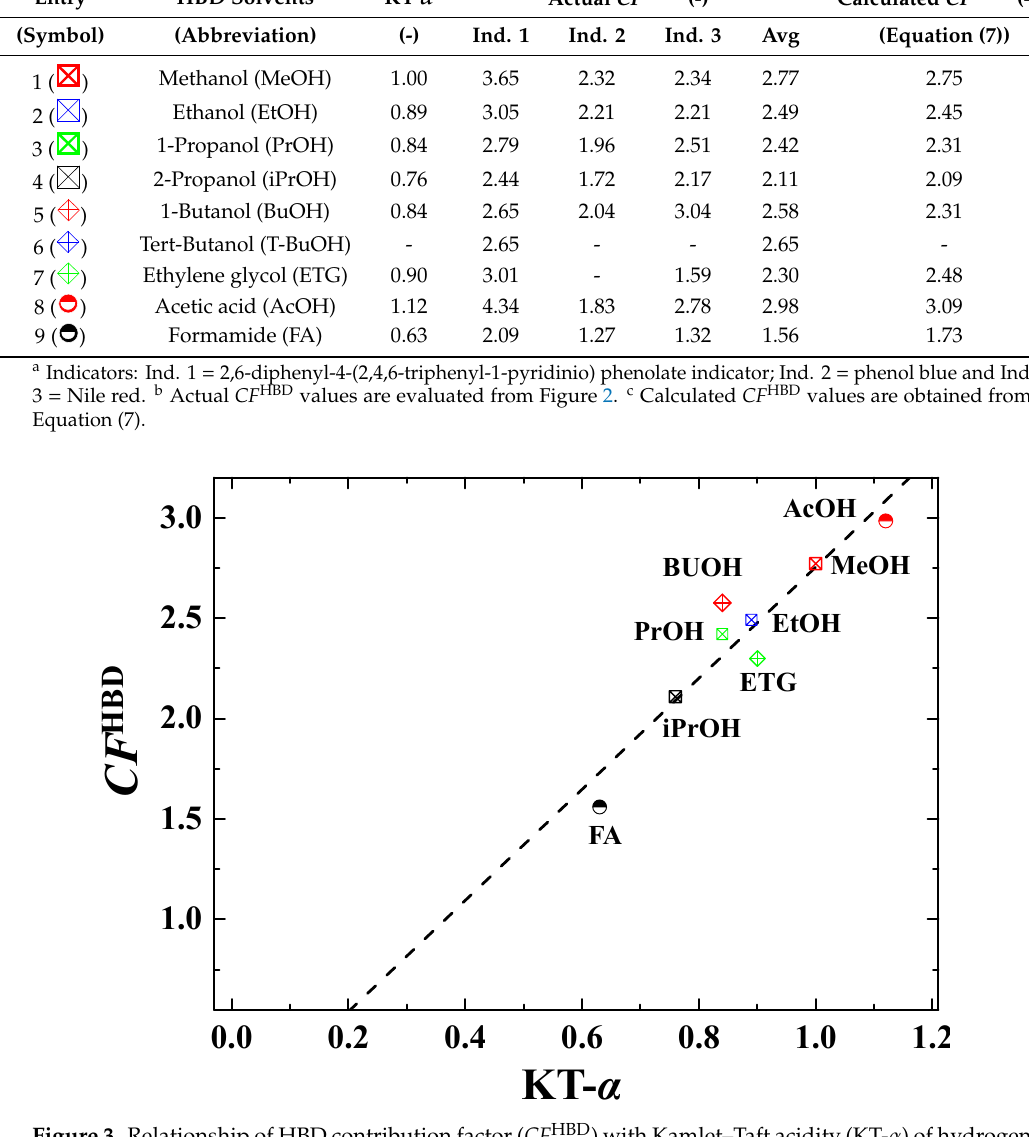
Table 1. Pure properties of hydrogen bond donor (HBD) at 25 ◦ C showing Kamlet–Taft acidity